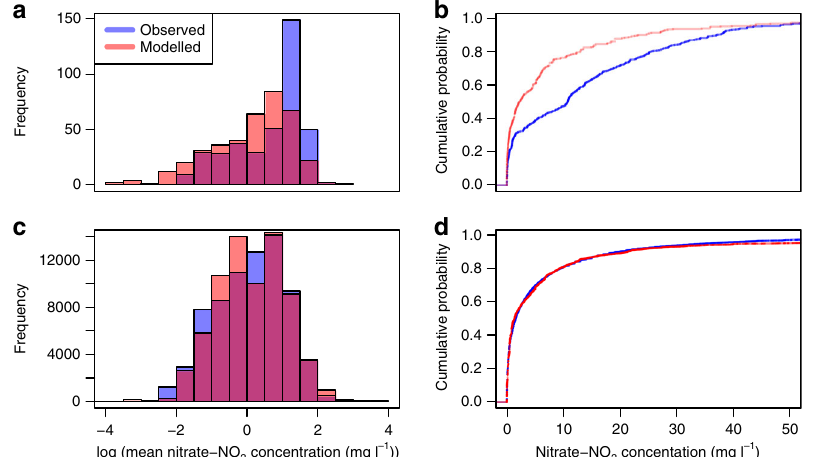
Fig. 3 Observed and modelled distributions of nitrate concentrations in groundwater. Distributions of observed (blue) nitrate concentrations in groundwater and modelled (red) nitrate concentrations in recharge at the water table for the European Union 29 ( a , b ) and the United States 30 ( c , d ). Purple colour in the histogram indicates where the model and observed concentration distributions overlap